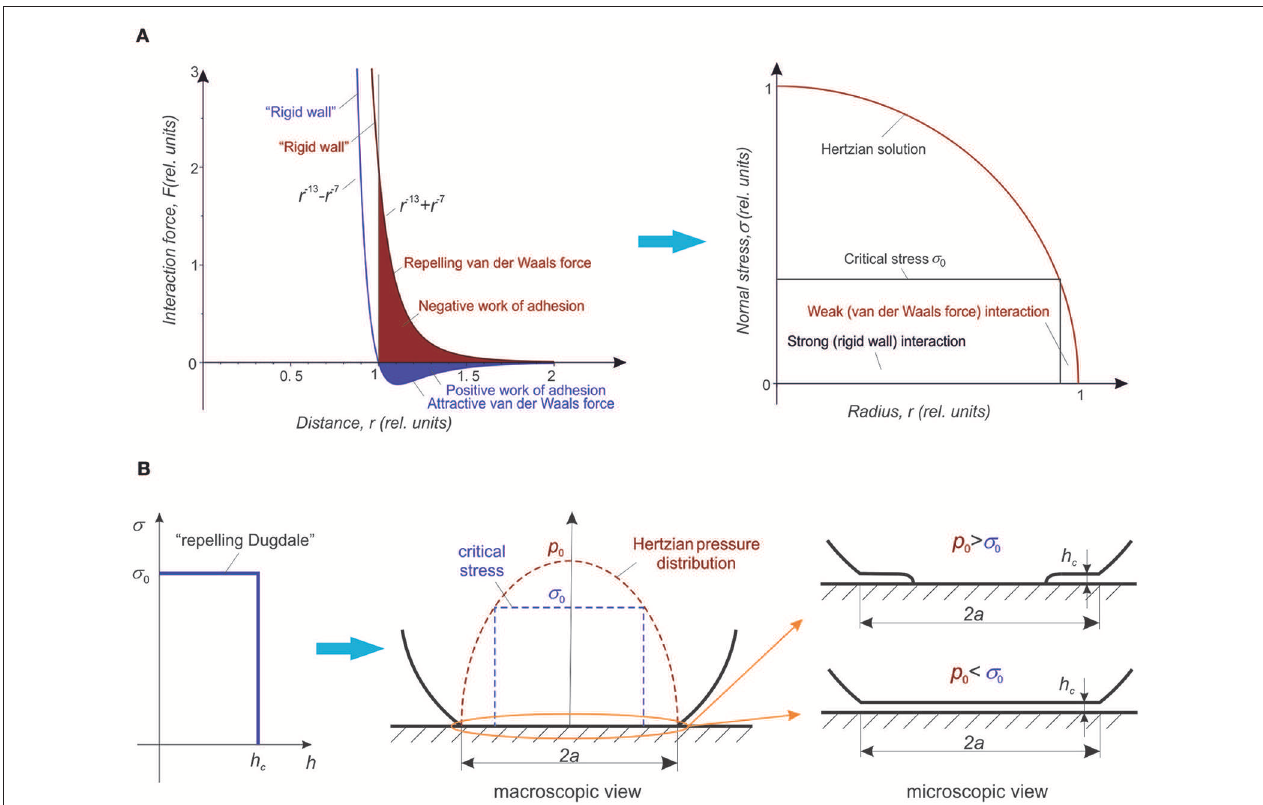
FIGURE 1 | (A) Left: Model intermolecular force in the case of attractive van der Waals force (blue line) and repelling van der Waals force (red line), in relative units. The distance r = 1 corresponds to the equilibrium in the case of attractive van der Waals forces. At distances smaller than r = 1 the repelling force increases steeply: At these distances, one can qualitatively speak about a “rigid wall.” At distances r > 1, there exist weak long-range van der Waals force, either positive or negative. The work needed to separate the surfaces starting from the “rigid wall” position r = 1 are shown by filled areas (blue filled area—positive work of adhesion in an adhesive contact, red filled area—“negative work of adhesion” in the repelling case). (A) Right: The normal stress (pressure) distribution in a Hertzian contact. If the range of action of both core “rigid wall” force and van der Waals force are negligible compared with all characteristic length scales of the contact problem, the repelling van der Waals forces do not influence the contact problem and do not change the stress distribution. However, on the microscopic scale, in the regions where the stress is larger then a critical stress σ 0 (see the text of paper for details), the surfaces are in “direct rigid wall contact” and feel strong atomic corrugation potential. In the regions where the stress is smaller than σ 0 , they “levitate” due to van der Waals force and see only weak corrugation. By decreasing the normal force, one can achieve the state in which the normal stress is smaller than σ 0 in the whole contact area. This state corresponds to the state of superlubricity. (B) Schematic illustration of the contact configuration on the example of a simple model adhesive stress of “Dugdale type” (Dugdale, 1960) with a constant repelling stress σ 0 up to the distance h c (scheme on the left). In the center: Macroscopic shape of a soft sphere in contact with a rigid surface (black line) and the Hertzian stress distribution (brown dashed line). On the right: Microscopic view of the contact gap in the undercritical and overcritical cases. From the macroscopic point of view, the gap in both cases is zero, from the micrsocopic point of view, the bodies can be either in direct rigid wall contact (where the local Hertzian pressure is larger σ 0 or “levitate” in the distance h c where the Hertzian pressure is smaller σ 0